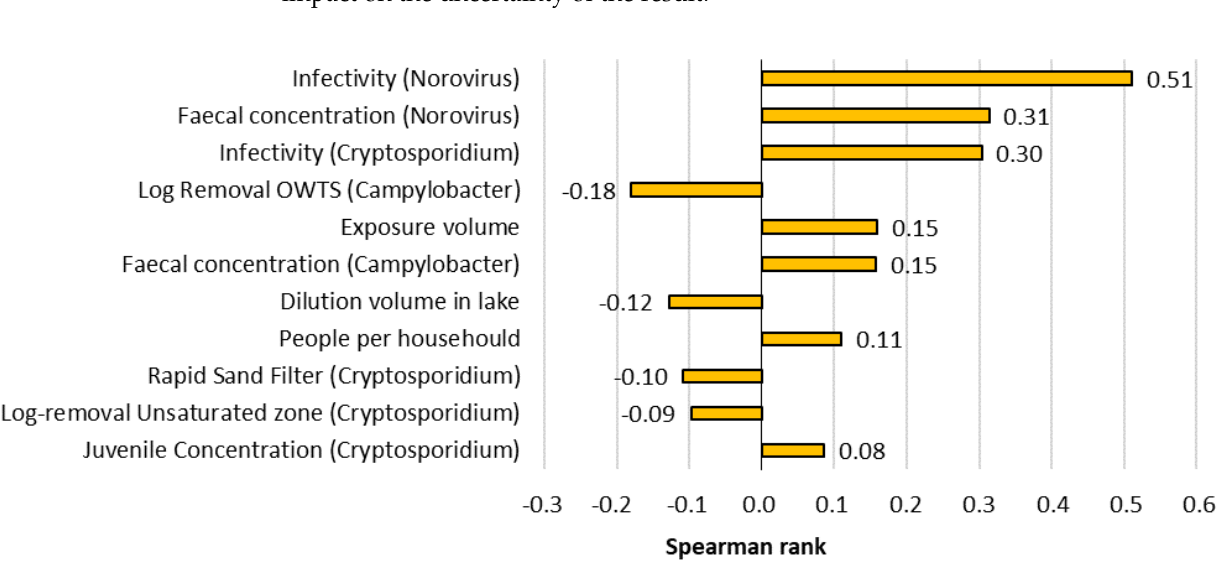
Figure 3. Plot of the total risk of the hazardous events prior and after the UF membrane installation, plotting each event’s cumulative probability of occurrence against its mean consequence. The total risk reduction of the UF membranes is illustrated by the green area, while the total remaining risk is illustrated in blue.